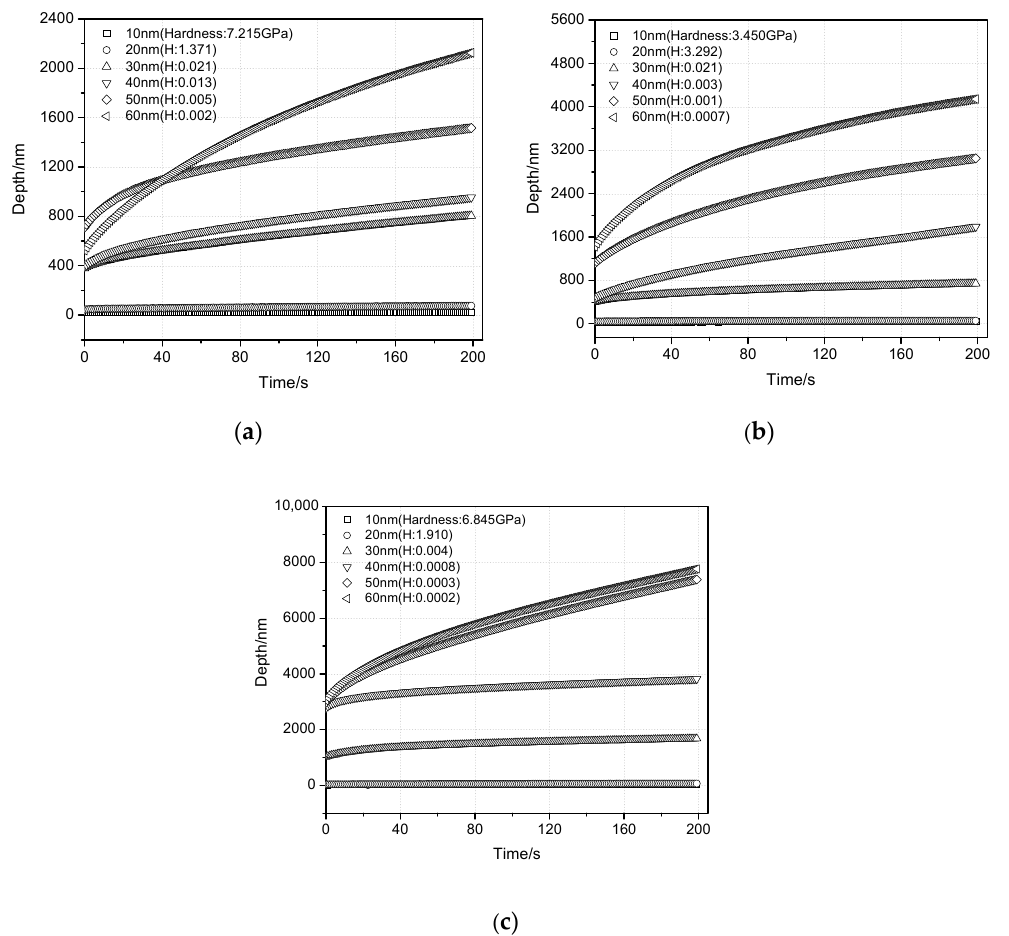
Figure 11. Creep curves of indentation points during the dwell time. ( a ) BA, ( b ) DA, and ( c ) LA.